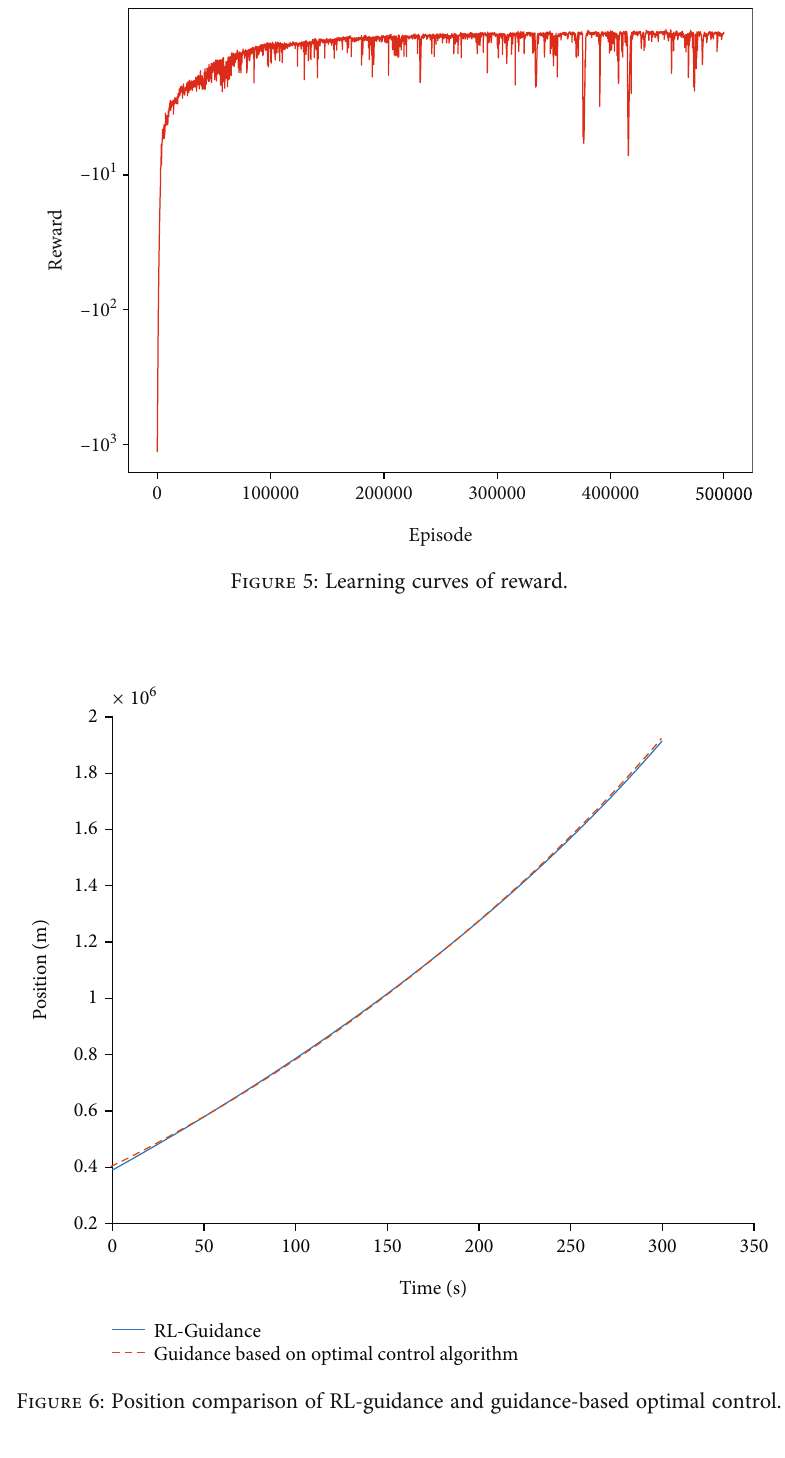
Figure 6: Position comparison of RL-guidance and guidance-based optimal